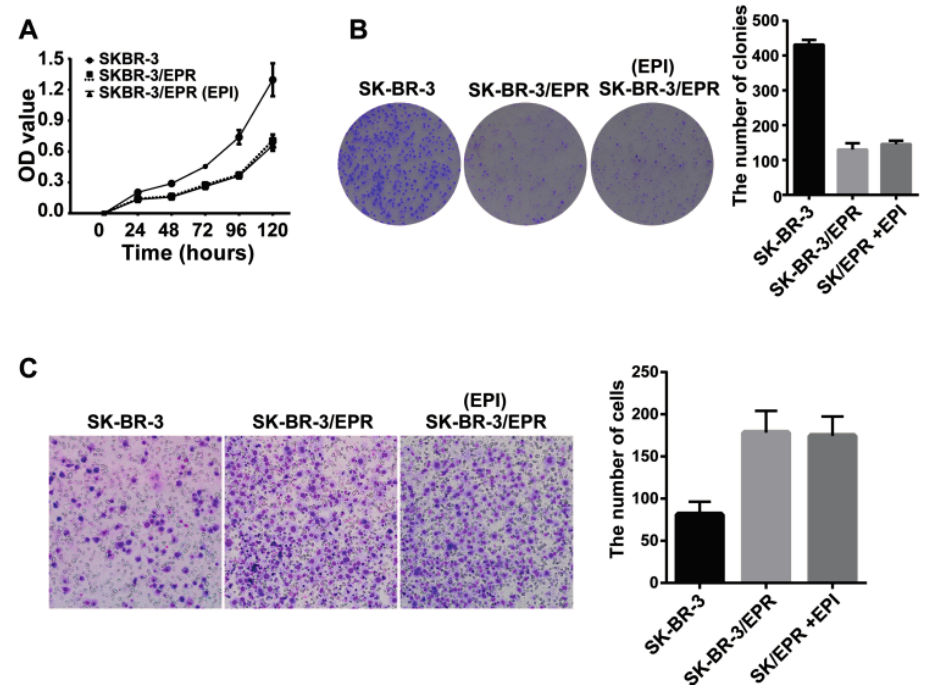
Figure 4. The SK-BR-3/EPR cells exhibited a marked reduction in cell proliferation rate, and enhancement in cell invasion ability. ( A ) The SK-BR-3/EPR cells showed decreased cell proliferation rate in the presence or absence of epirubicin in comparison with that of drug sensitive SK-BR-3 cells; ( B ) The SK-BR-3/EPR cells showed a remarkably reduction in the formation of cell colonies compared with that of in drug sensitive SK-BR-3 cells. Cells were seeded in 35-mm dishes at a density of 500 cells per dish and then cultured for 10–14 days, the number of colonies was counted under an inverted microscope, and only colonies of more than 50 individual cells were counted (×20 magnification). The assays were performed in triplicate for each group and repeated three times; ( C ) The SK-BR-3/EPR cells exhibited enhanced invasive ability compared with that of drug sensitive SK-BR-3 cells. The cells were cultured to 80% confluence, and harvested by trypsinization, then the cell suspension at a density of 4 × 105 cells/mL were added into the matrigel pre-coated transwell insert. The lower insert was fi lled with 10% FBS-containing medium. After incubation for 24 h at 37 °C, the invaded cells were fixed, stained, and counted. The assay was performed in triplicate and repeated three times (×200